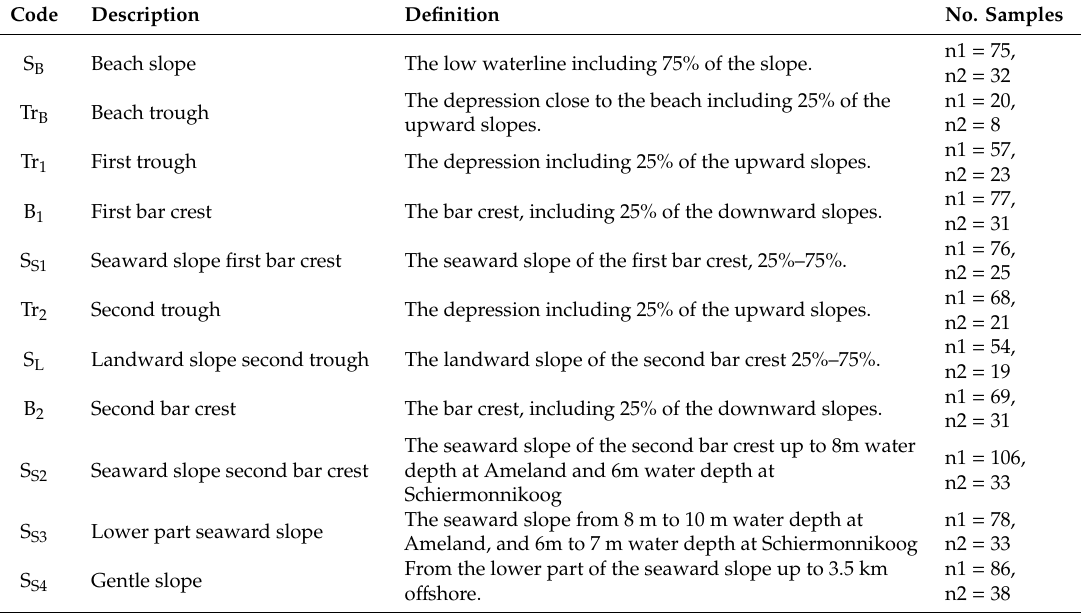
Table 1. Definition of the morphological features in the